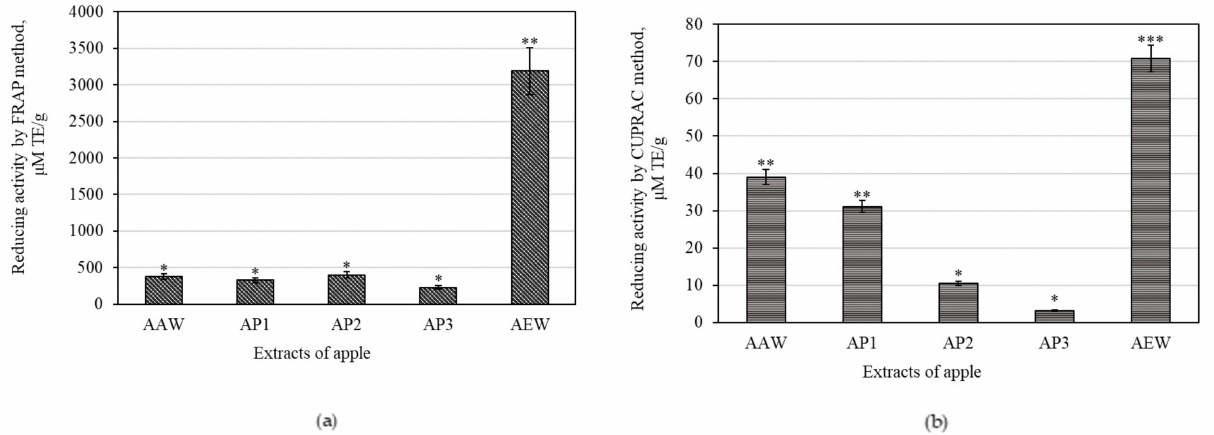
Figure 6. Reduction activity of the of whole apple and apple peel extracts: ( a ) reducing activity evaluated by the CUPRAC method; ( b ) reducing activity determined by the FRAP method. Different signs (*) indicate statistically significant differences at p > 0.05, according to Tukey’s multiple comparison